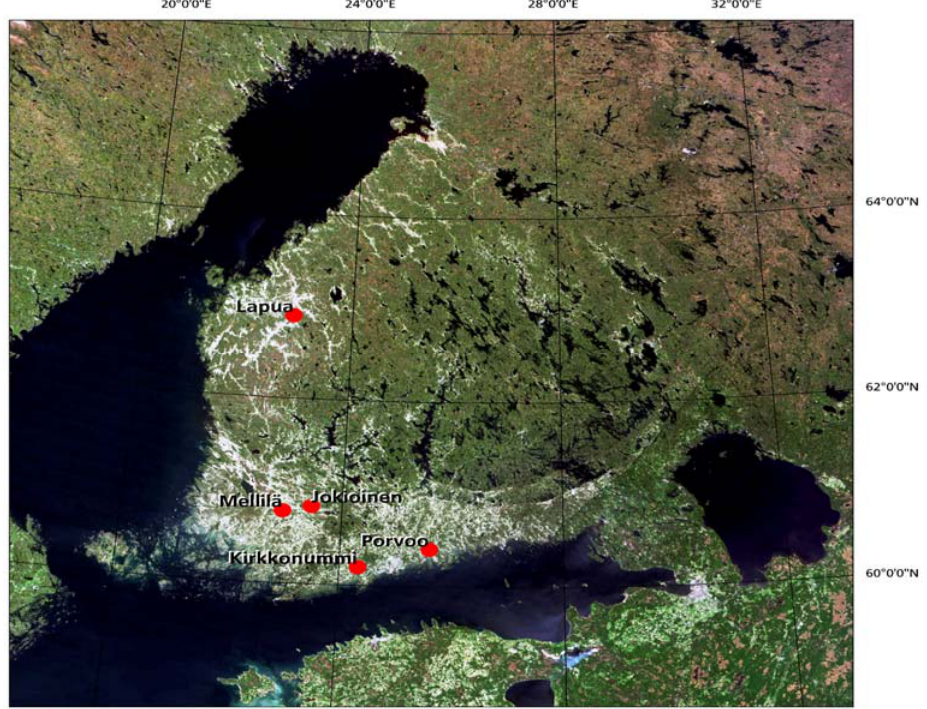
Figure 2. Satellite and ground truth measurement locations in Finland (Original Data (C) NASA,